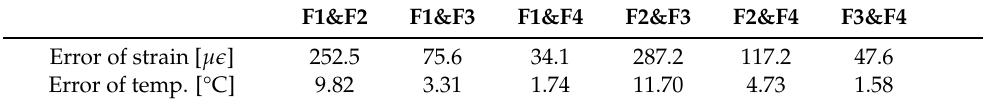
Table 2. Evaluated error of simultaneous measurements when combining two types of fibers.